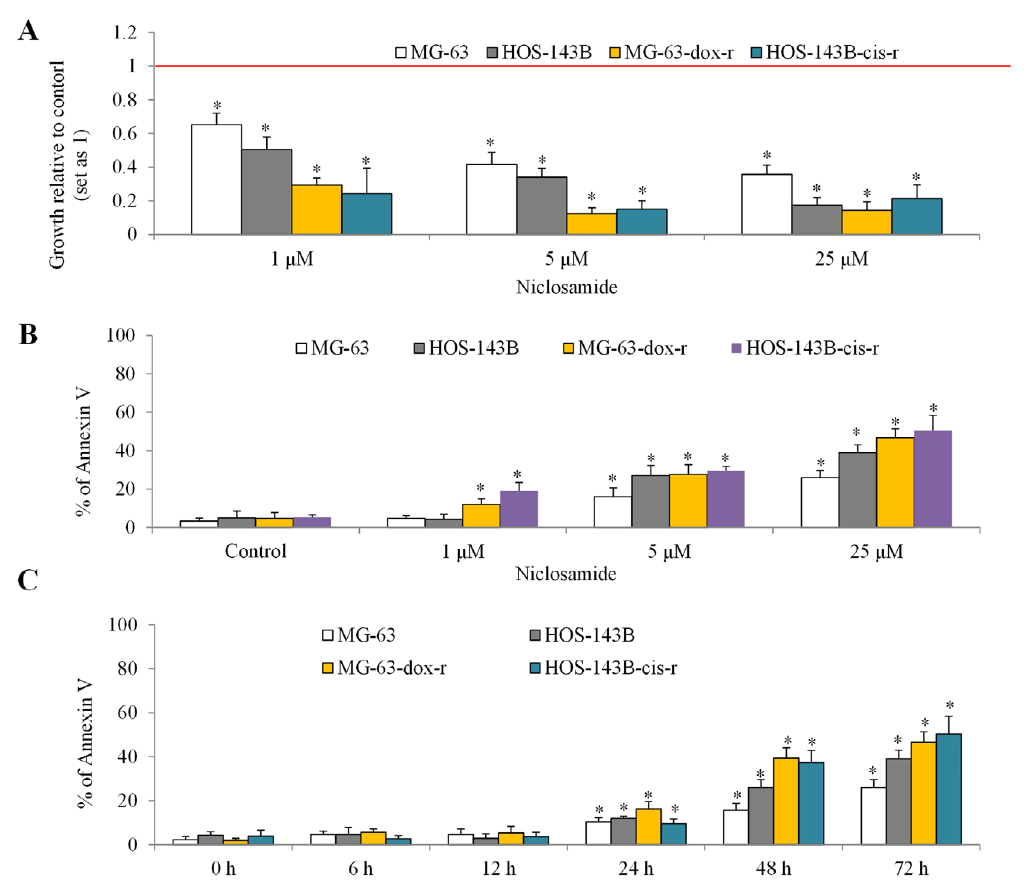
Figure 3 – Niclosamide decreases proliferation and induces apoptosis in parental and chemo-resistant osteosarcoma cells. (A) Niclosamide at 1, 5 and 25 µM significantly decreases proliferation in MG-63, HOS-143B, MG-63-dox-r and HOS-143B-cis-r cells. (B) Niclosamide at 1, 5 and 25 µM significantly induces apoptosis in MG-63, HOS-143B, MG-63-dox-r and HOS-143B-cis-r cells. Cells were treated with drugs for 72 h prior to proliferation (as measured by BrdU incorporation) and apoptosis (as measured by flow cytometry of Annexin V) assays. (C) Time course analysis of apoptosis on niclosamide on parental and chemo-resistant osteosarcoma cells. *, p<0.5, compared to control. Unpaired Student’s t test was